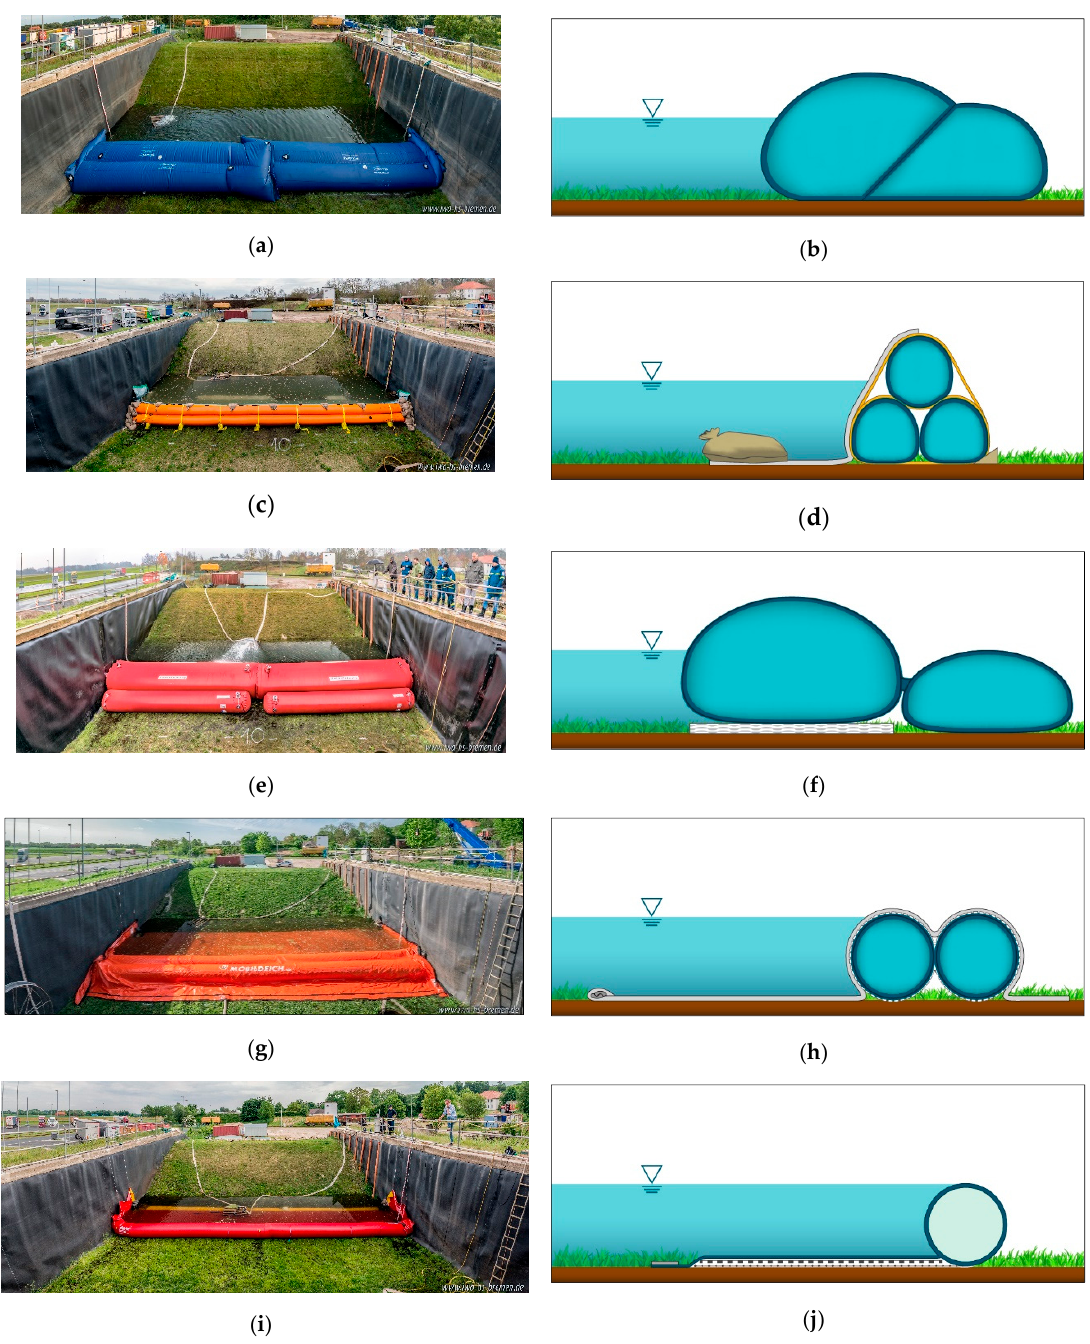
Figure 5. Tube systems tested in the IWA test facility, ( a ) Hydrobaffle (water-filled), ( b ) schematic diagram of the Hydrobaffle system, ( c ) Tiger Dam, (water-filled), ( d ) schematic diagram of the Tiger Dam system, ( e ) Flutschutz Doppelkammerschlauch (DKS) (water-filled), ( f ) schematic diagram of the Flutschutz DKS system, ( g ) Mobildeich, (water-filled), ( h ) schematic diagram of the Mobildeich system, ( i ) Öko-Tec (air-filled), ( j ) schematic diagram of the Öko-Tec system.